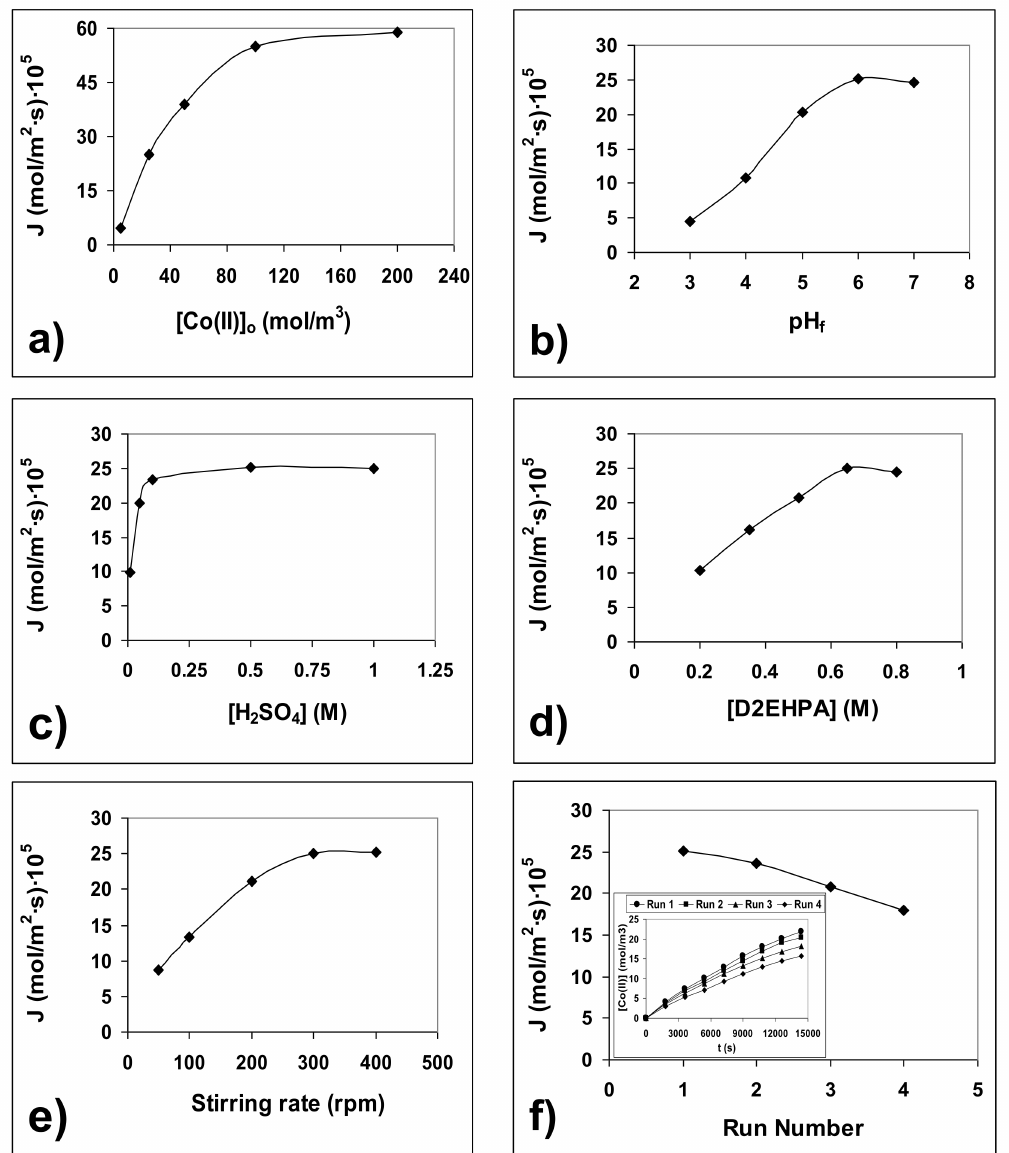
Figure 4. Influence on Co(II) flux of: ( a ) initial feed pH; ( b ) sulfuric acid concentration in product phase; ( c ) carrier concentration in membrane phase; ( d ) stirring rate in both aqueous and product phases; ( e ) initial Co(II) concentration in feed phase; ( f ) successive runs with the same